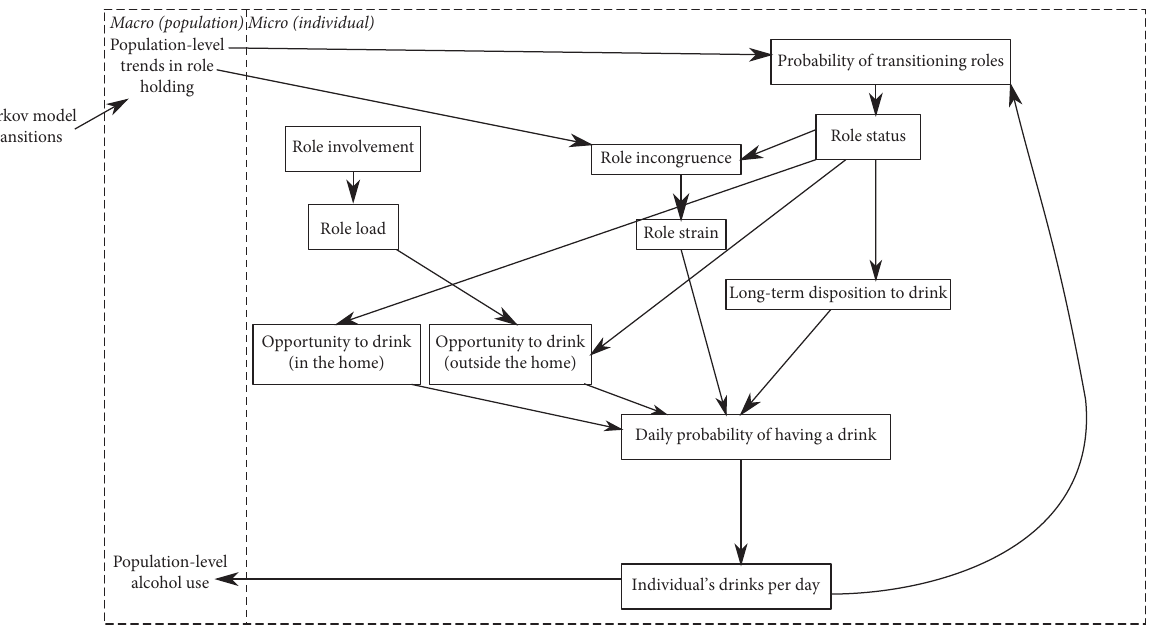
Figure 3: Schematic of roles